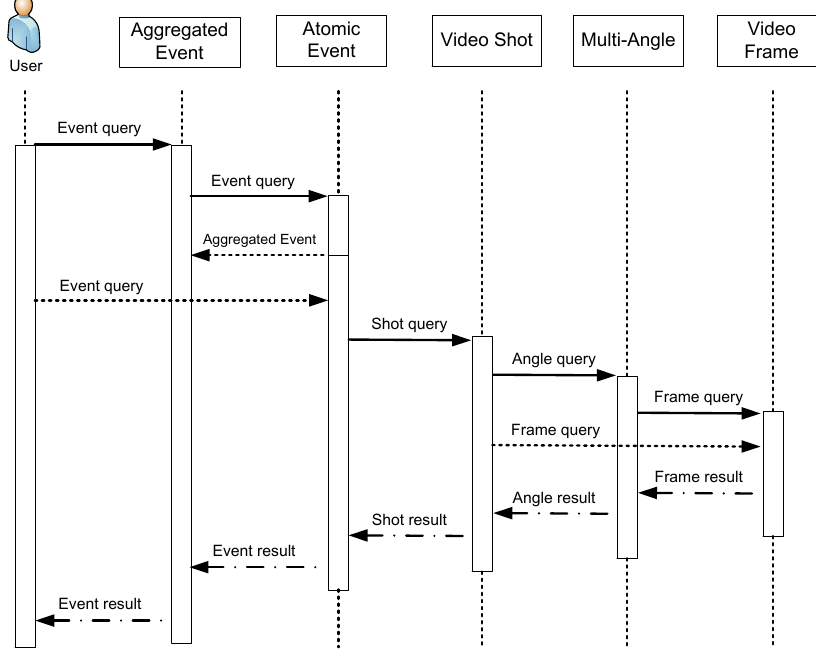
Figure 1. Video scheduling